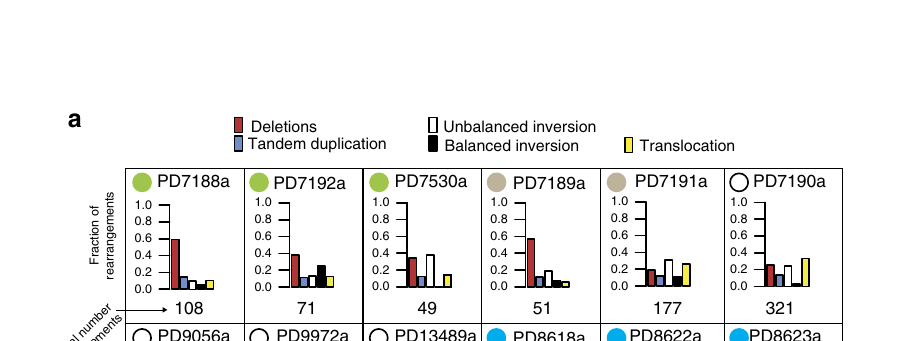
Rearrangementcataloguesoftumoursweresearchedinformaticallyforthepresenceofbalancedinversions.Thebasicprincipleofthesearchwastofindpairsofhead-to-headandtail-to-tailinversionsin which the breakpoint coordinates overlap at both ends. Compared with all 286 primary tumours, balanced inversions were significantly enriched in radiation-associated second malignancies ( P ¼ 2 (cid:2) 10 (cid:3) 16 , generalized linear model) and also in BRCA1 or BRCA1 deficient breast tumours ( P ¼ 2 (cid:2) 10 (cid:3) 16 , generalized linear model). Further, compared to BRCA1 or BRCA1 deficient breast tumours balanced inversions were significantly enriched in radiation-associated second malignancies ( P ¼ 0.0006, generalized linear model).